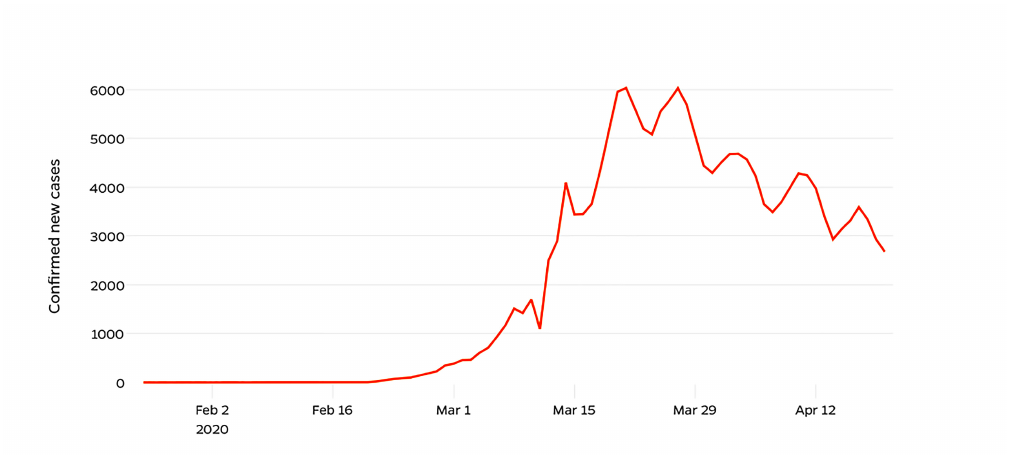
Figure 1 - The outbreak evolution curve of confirmed COVID-19 new cases in Italy from Feb 2 to April 12